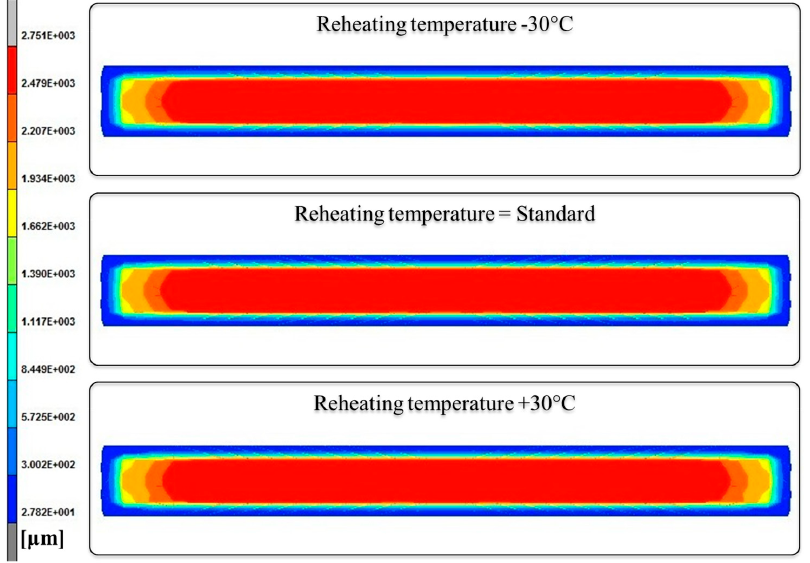
Figure 9. Effect of the reheating temperature on the ferrite grain size after the second roughing pass.